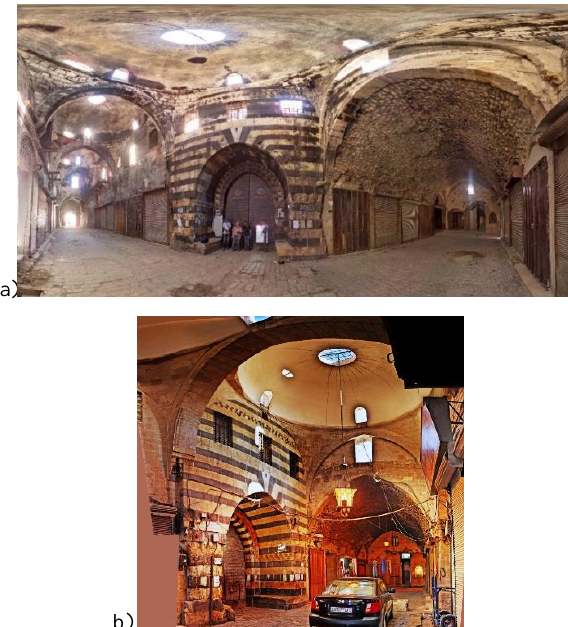
Figure 1: The old souq, current situation (a) and how it was in 2010 (b).